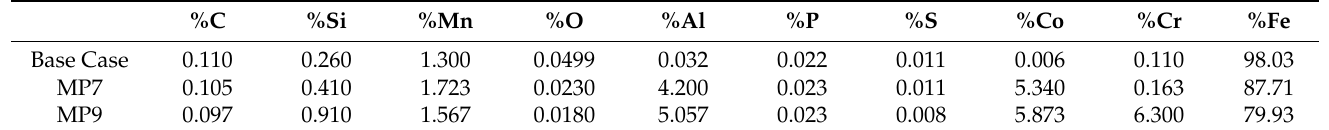
Table 3. Bulk chemical composition of weld metals (mass%).